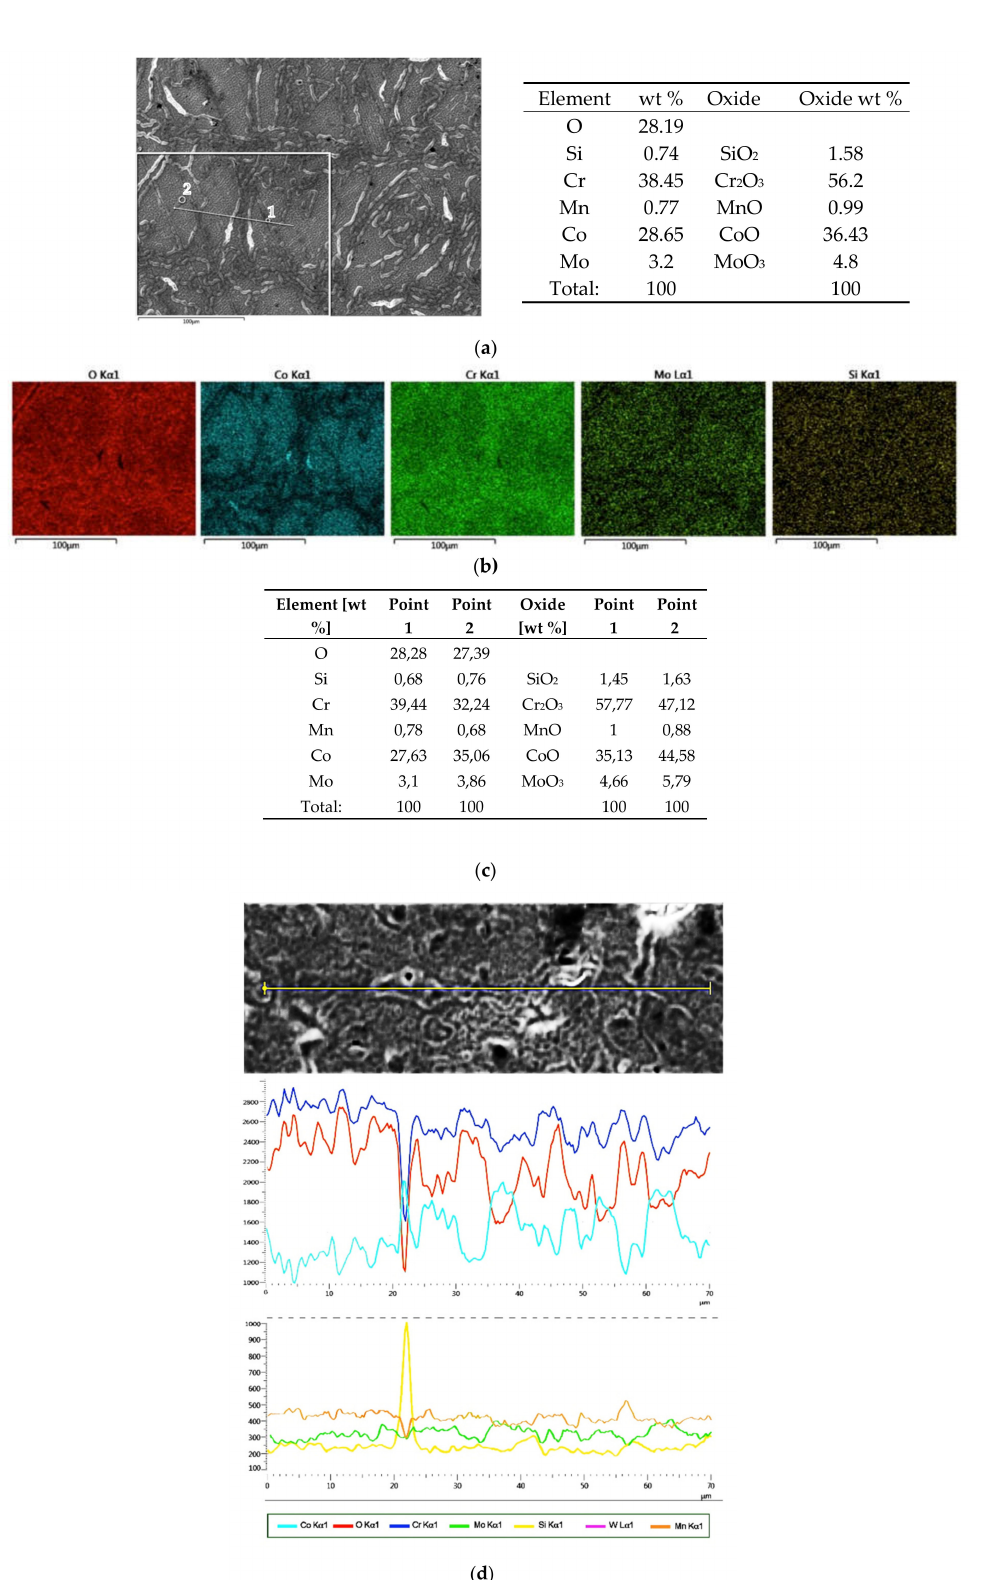
Figure 5. SEM EDS results for the MSM sample: ( a ) SEM-SE micrograph showing the morphology with average EDS results from the marked area; ( b ) maps presenting the surface distribution of O, Co, Cr, Mo, and Si; ( c ) EDS results for marked points; ( d ) SEM-SE micrograph with corresponding EDS line scan